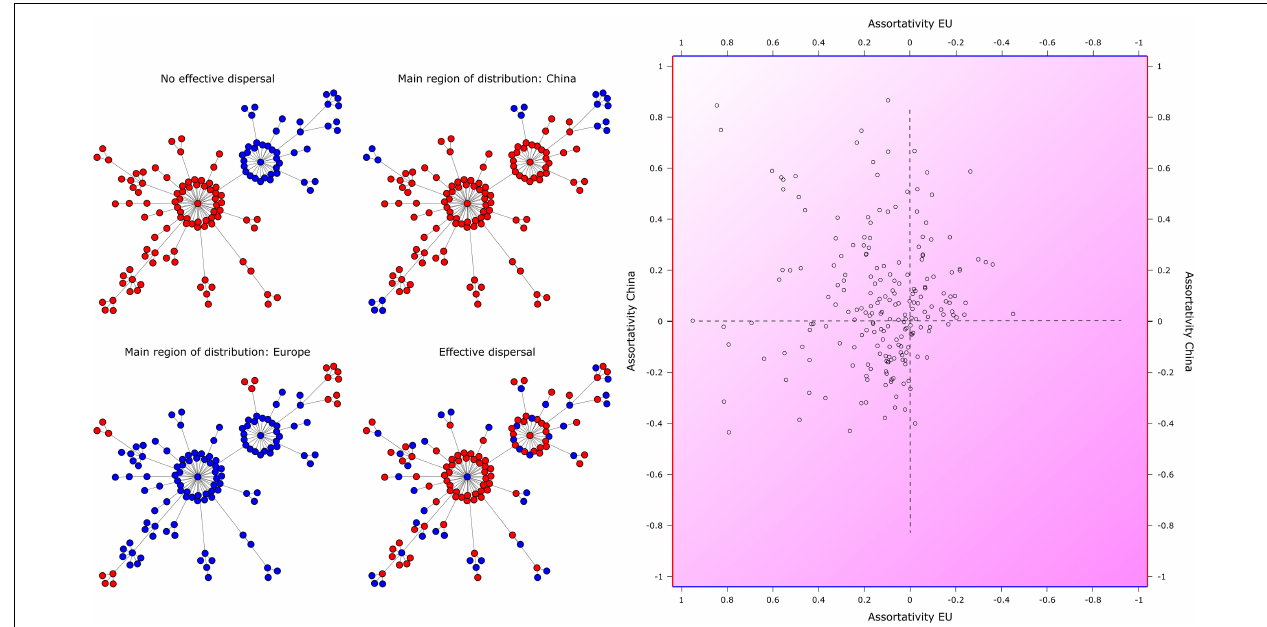
FIGURE 7 | Significant assortativity patterns of amplicons within 211 shared Swarm OTUs detected in Chinese and European (EU) coastal waters. (Left panel) Mock shared Swarm OTUs representing the four combinations of assortative and disassortative patterns (in these mock Swarms, node sizes were not scaled to read abundances). (Right panel) Each data point refers to a shared OTU and the respective assortativity values of its amplicons determine its placement in one of the four quadrants. (Upper left) Assortative grouping of amplicons from each region (indicating limited effective dispersal; 77 OTUs); (upper right) assortative grouping of Chinese amplicons, disassortative grouping of European amplicons (China main distribution area; 49 OTUs); (lower left) assortative grouping of European amplicons, disassortative grouping of Chinese amplicons (Europe main distribution area; 73 OTUs); (lower right) disassortative grouping of amplicons from each region (unlimited effective dispersal; 12 OTUs). Data points in the latter quadrant are scarce, since our analyses focused on OTUs which exhibited significantly higher assortativity values than expected by chance for sequences of both